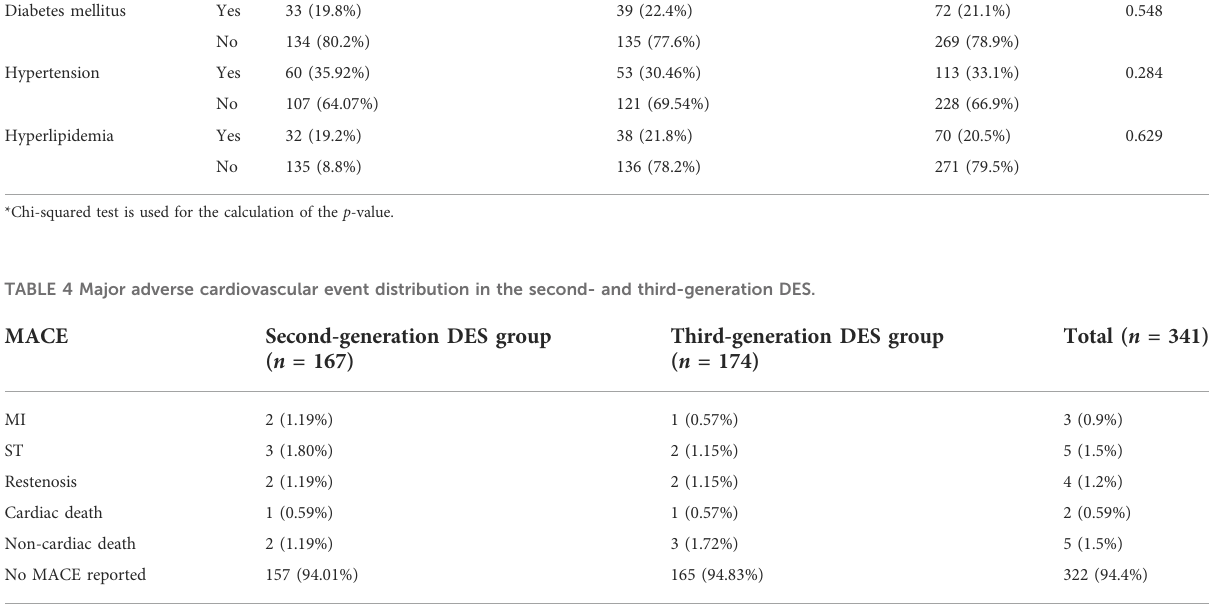
*Chi-squared test is used for the calculation of the p -value.